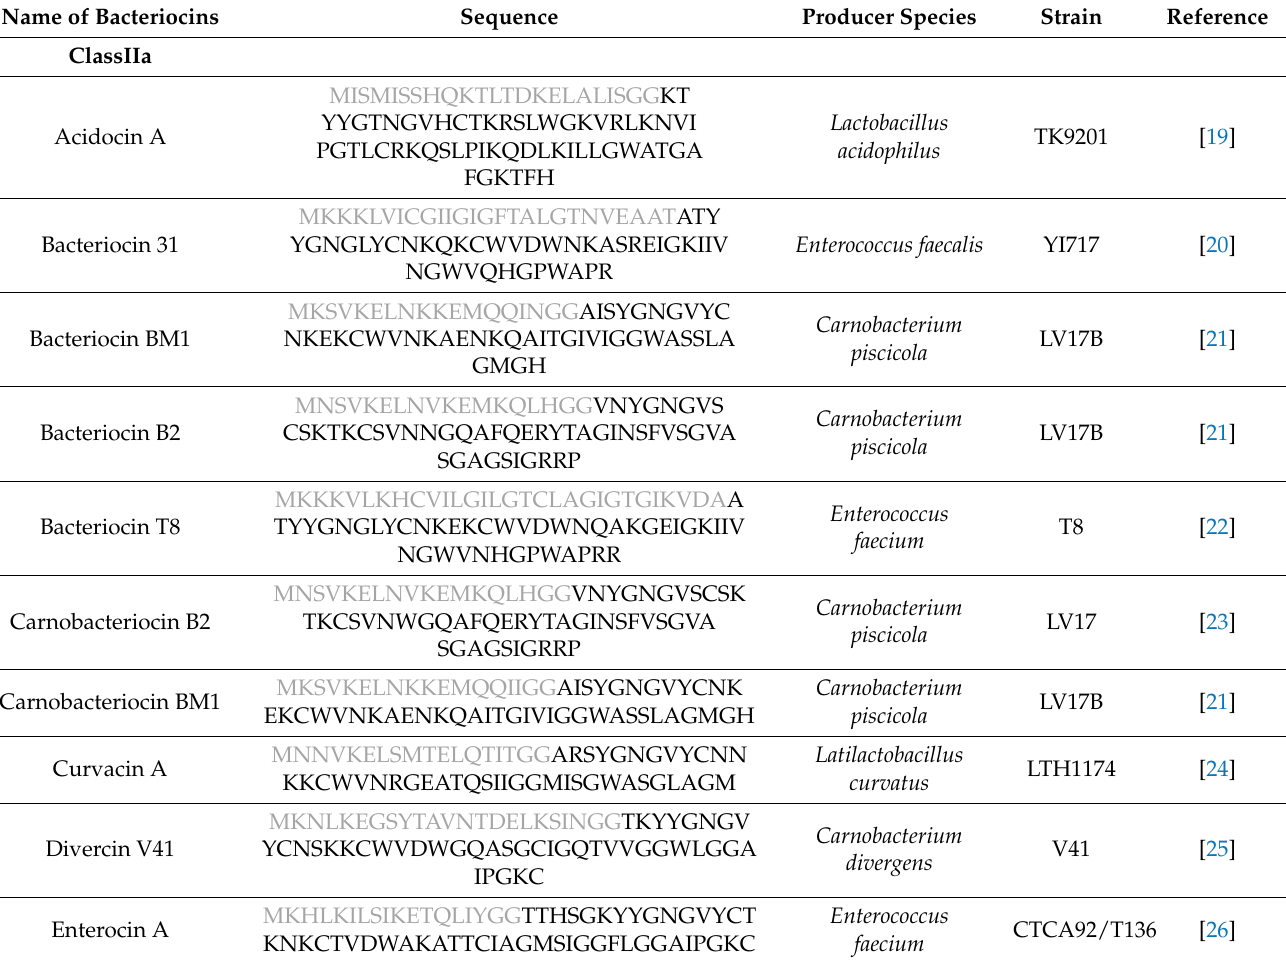
Table 1. Amino acids sequences of class II